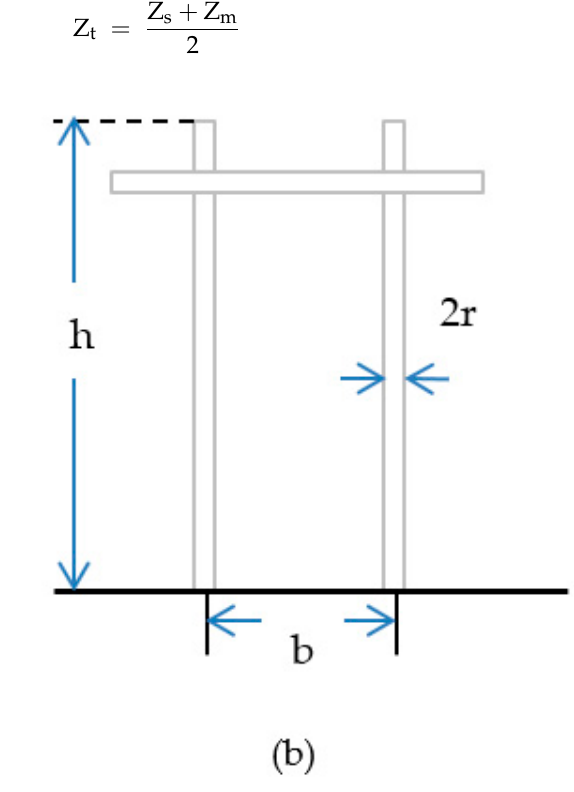
Figure 1. ( a ) The orientation of the power rails. ( b ) The H-frame tower